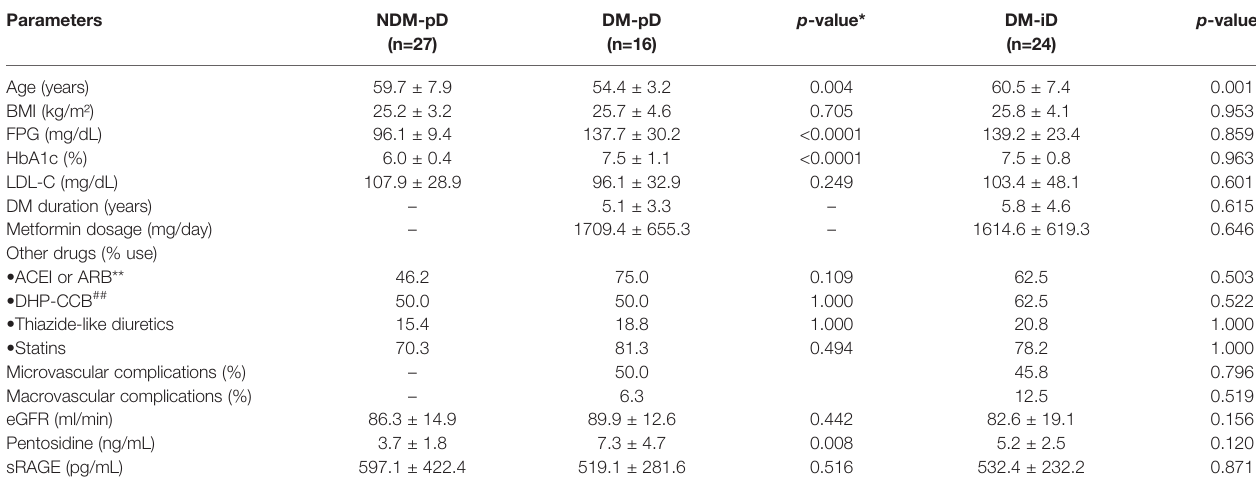
TABLE 3 | Factors determining osteogenic differentiation in type 2 diabetes. Parameters